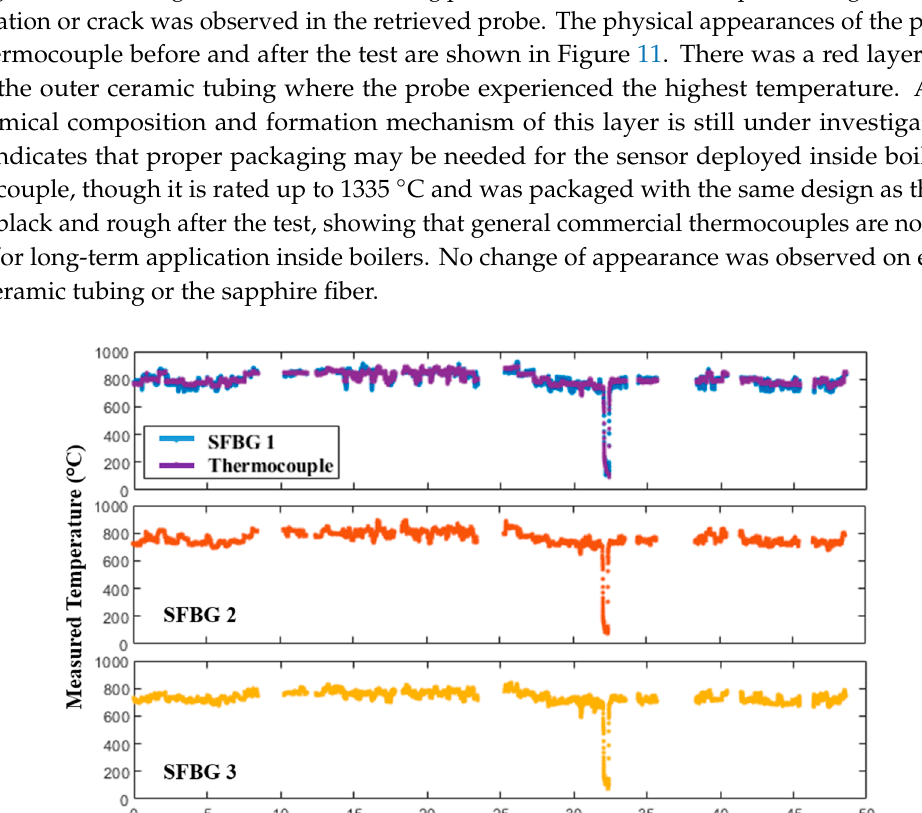
Figure 11. Picture of the physical appearances of the packaging and thermocouple before and after the test. 3.2.3. Interrogation System and User Interface The onsite interrogation system used in both the coal-fired and gas-fired boiler tests consists of all the parts listed in Section 2.3. Moreover, a weather-proof enclosure was used to protect the electronics from the field environment, as can be seen in Figure 12a. An onsite, user-friendly interface was developed via LabVIEW TM for use by sensor engineers and end-users (operators). As shown in Figure 12b, real-time diagnostics can be performed for the temperature probe. Relevant information, such as the raw and the filtered sensor spectral responses. as well as the peak fitting parameters, are readily accessible for tuning and trouble-shooting. Remote access to data is often desired in daily applications due to the flexibility. Driven by this need, a read-only remote interface was developed,